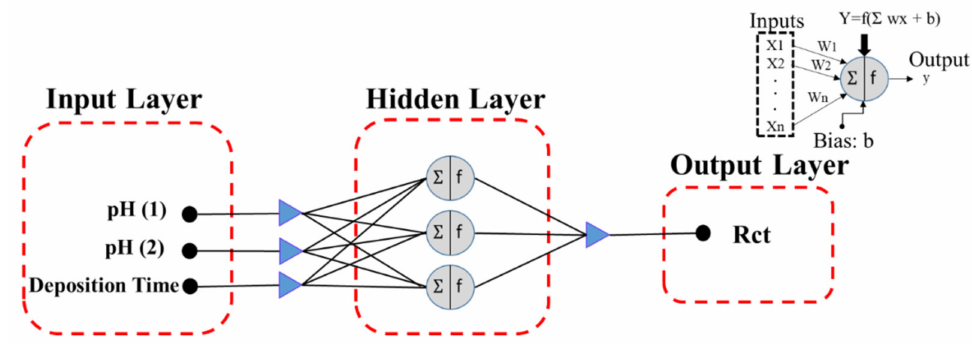
Figure 1. The structure for the ANN model utilized for modeling the corrosion behavior of CeCCs.